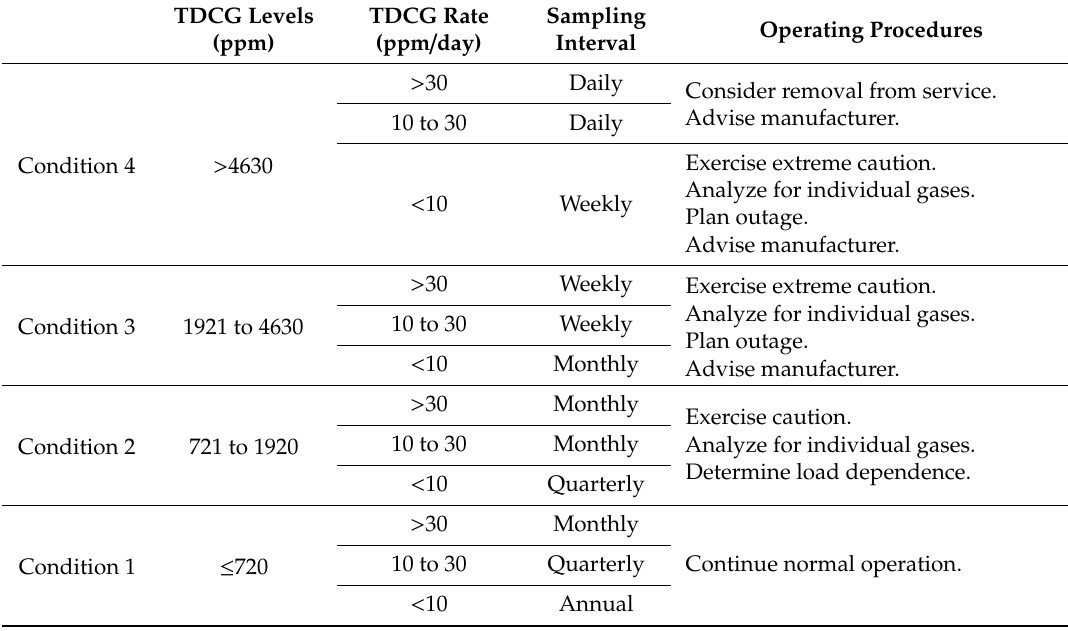
Table 3. Actions based on Total Dissolved Combustible Gas (TDCG)